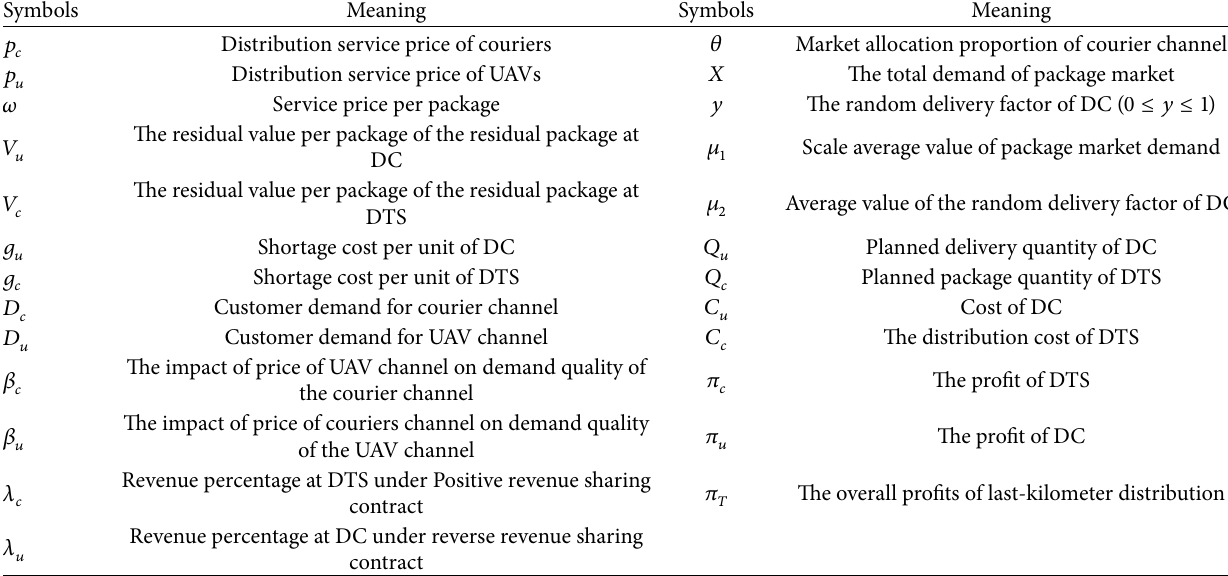
Table 1: The description of